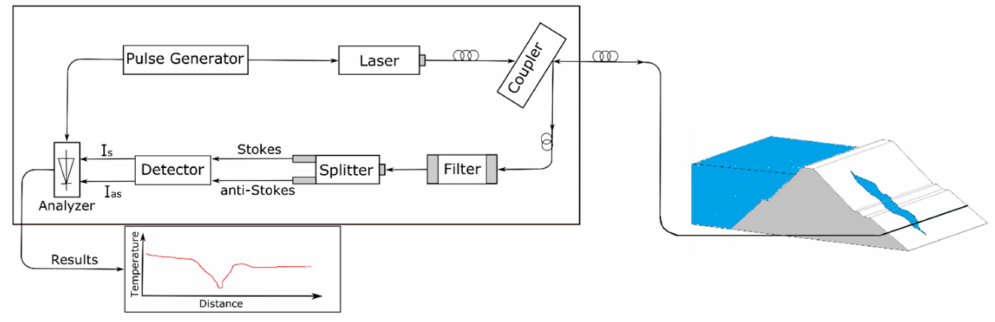
Figure 2. The basic components of an optical fiber DTS system. Adapted from [30]. (The publisher gave permission to reproduce this